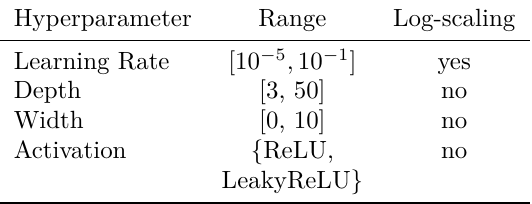
Table 4. Hyperparameters for training settings together with ranges for Bayesian Optimisation of ResNets